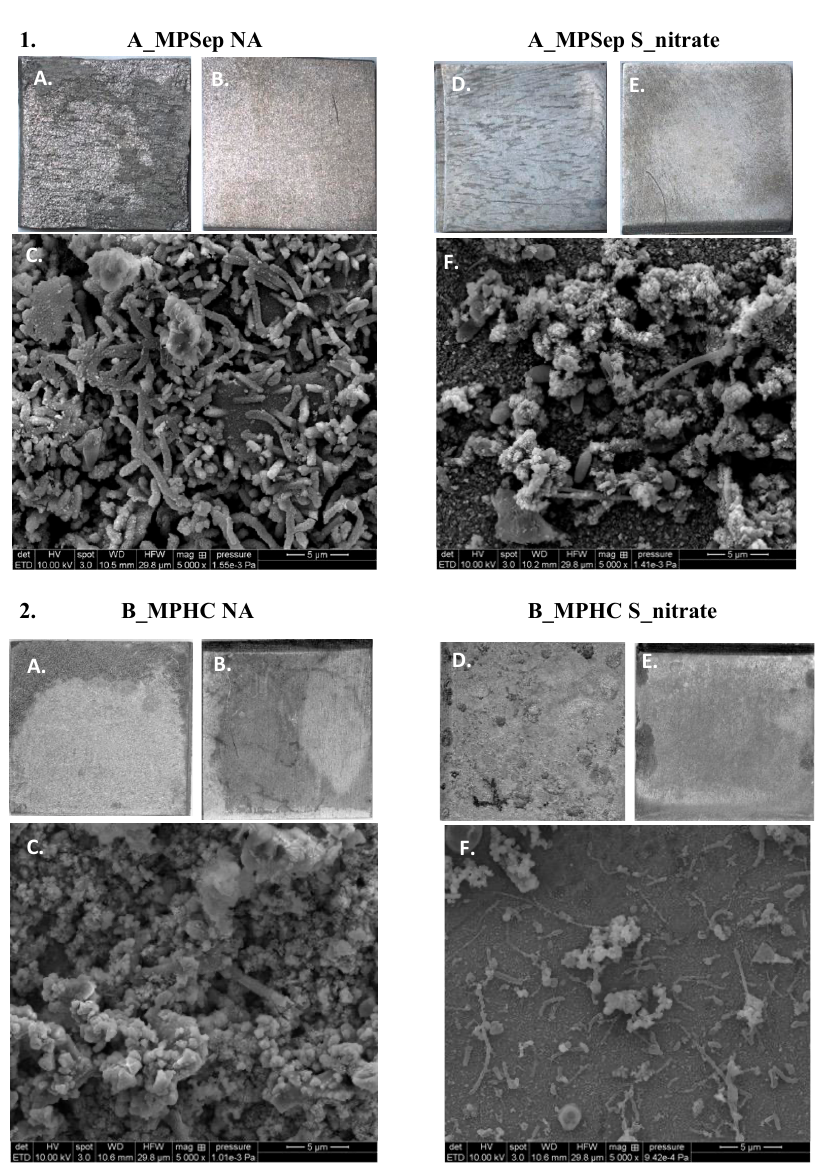
Figure 7. Scanning electron microscopy (SEM) and light microscopy images of the surface of the select corrosion coupons from one sampling location on each platform (Platform A— 1 , Platform B— 2 ) comparing the no-additive treatment (NA) and the nitrate plus sulfide treatment (S_nitrate). ( A , B , D , E ) display the light microscopy images (coupon dimensions are 1 cm × 1 cm), while ( C , F ) display the SEM images (5000× magnification) in subfigures 1 and 2 .